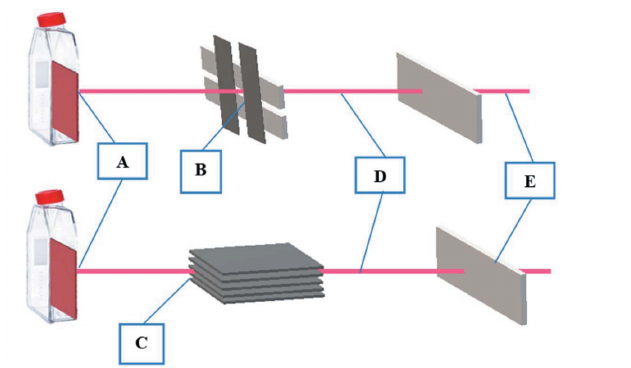
Figure 2 Schematic diagram of the irradiation setup for SBB and SMB. (A) Cell sample, (B) broad beam slit, (C) microbeam collimator, (D) synchrotron pink-beam, (E) beryllium window.